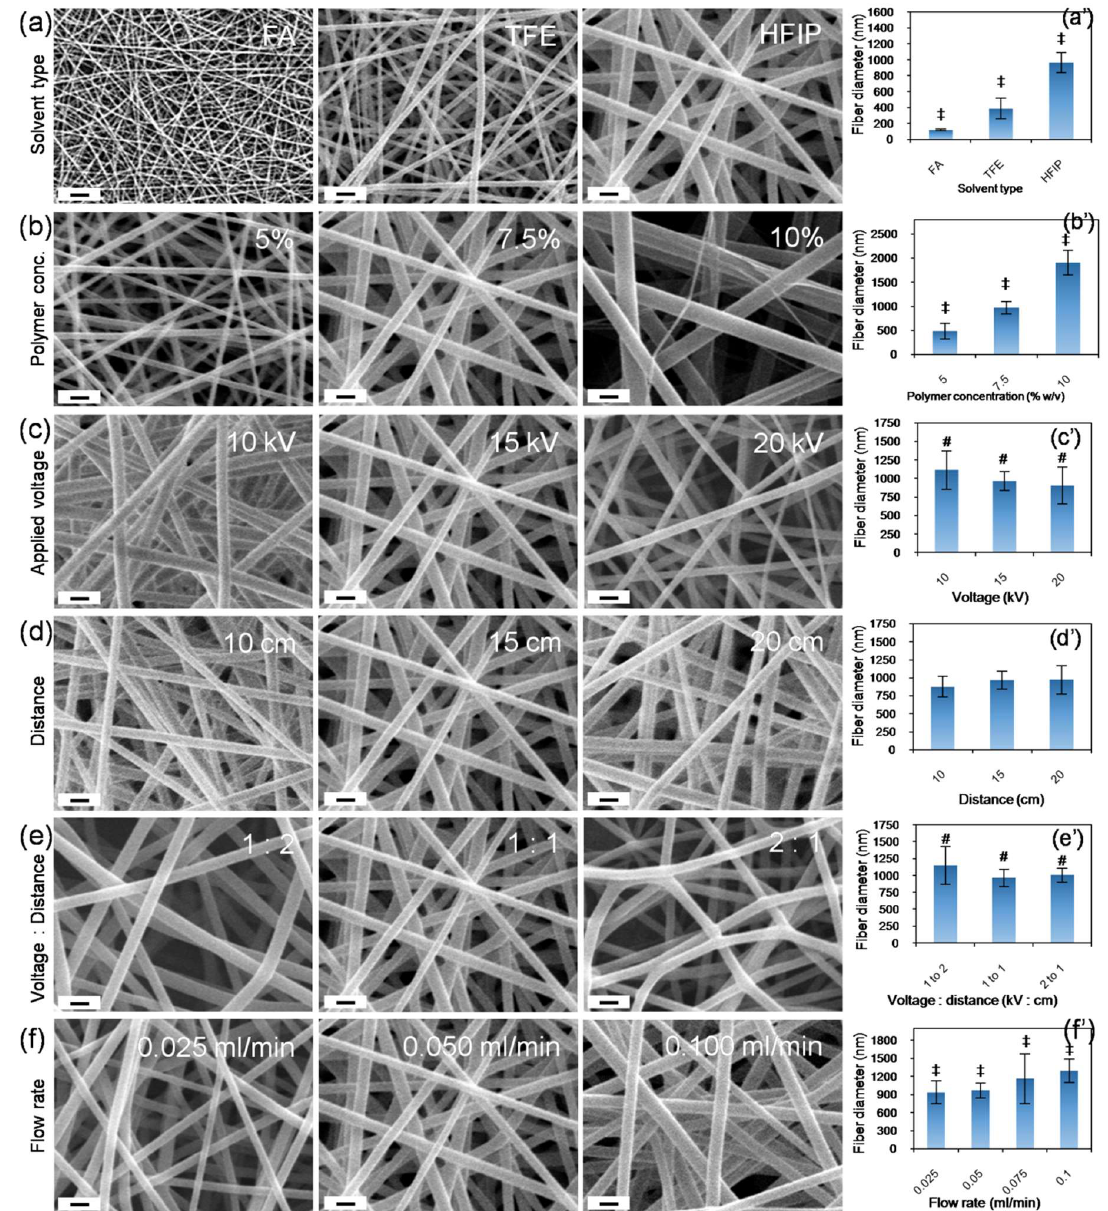
Figure 3. Effect of electrospinning parameters on fiber morphology: scanning electron microscopy (SEM) images of electrospun PA66 samples showing the effects of solvent type ( a ), polymer concentration ( b ), voltage ( c ), distance ( d ), voltage–to–distance ratio ( e ), and flow rate ( f ). Corresponding plots of fiber diameter are presented in ( a’ ) to ( f’ ) respectively. Fiber width was analyzed by manually measuring the width of individual fibers against a given scale using Image J software (n = 25). # and ‡ denotes statistical differences at p < 0.01 and p < 0.001 respectively. Scale bar = 2 µm.